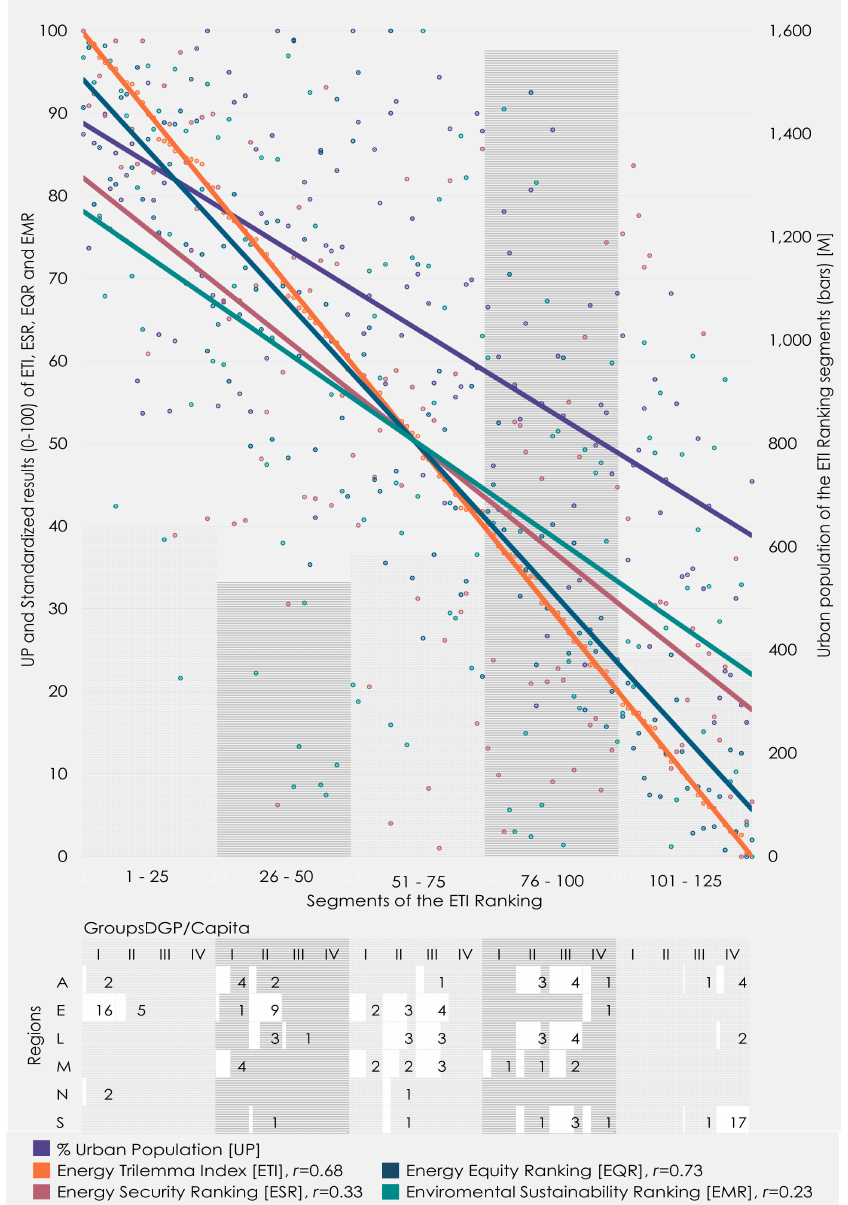
Figure 8. Correlation between the percentage of urban population and the ETI during the period 2014–2017. Source: Created by authors using data from